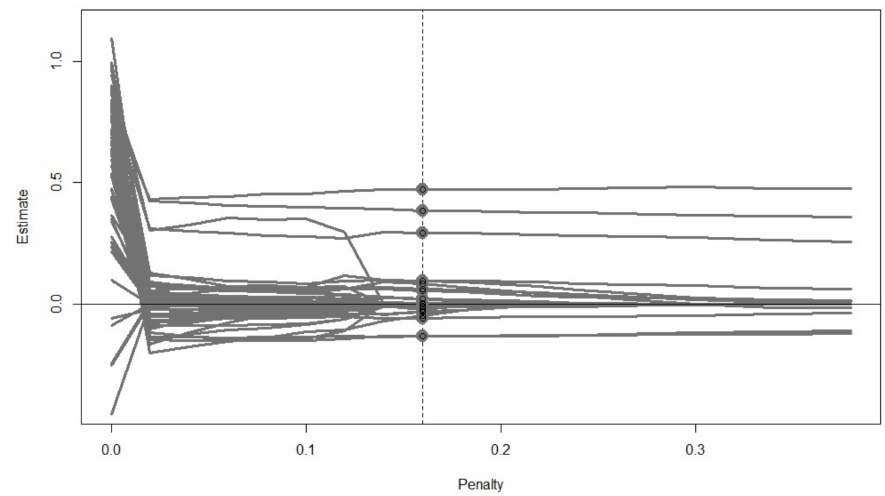
Figure 2. Parameter trajectories of the example SEM model. Based on BIC, the optimal penalty level is 0.16.